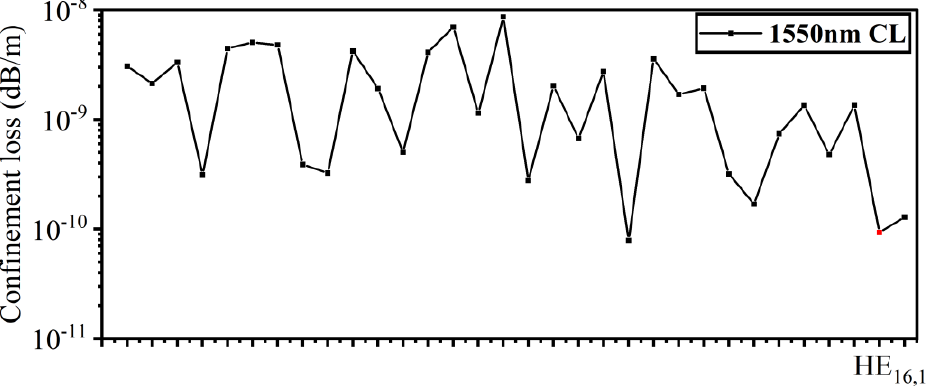
Figure 9. The distribution of CL for different vector modes at 1550 nm.